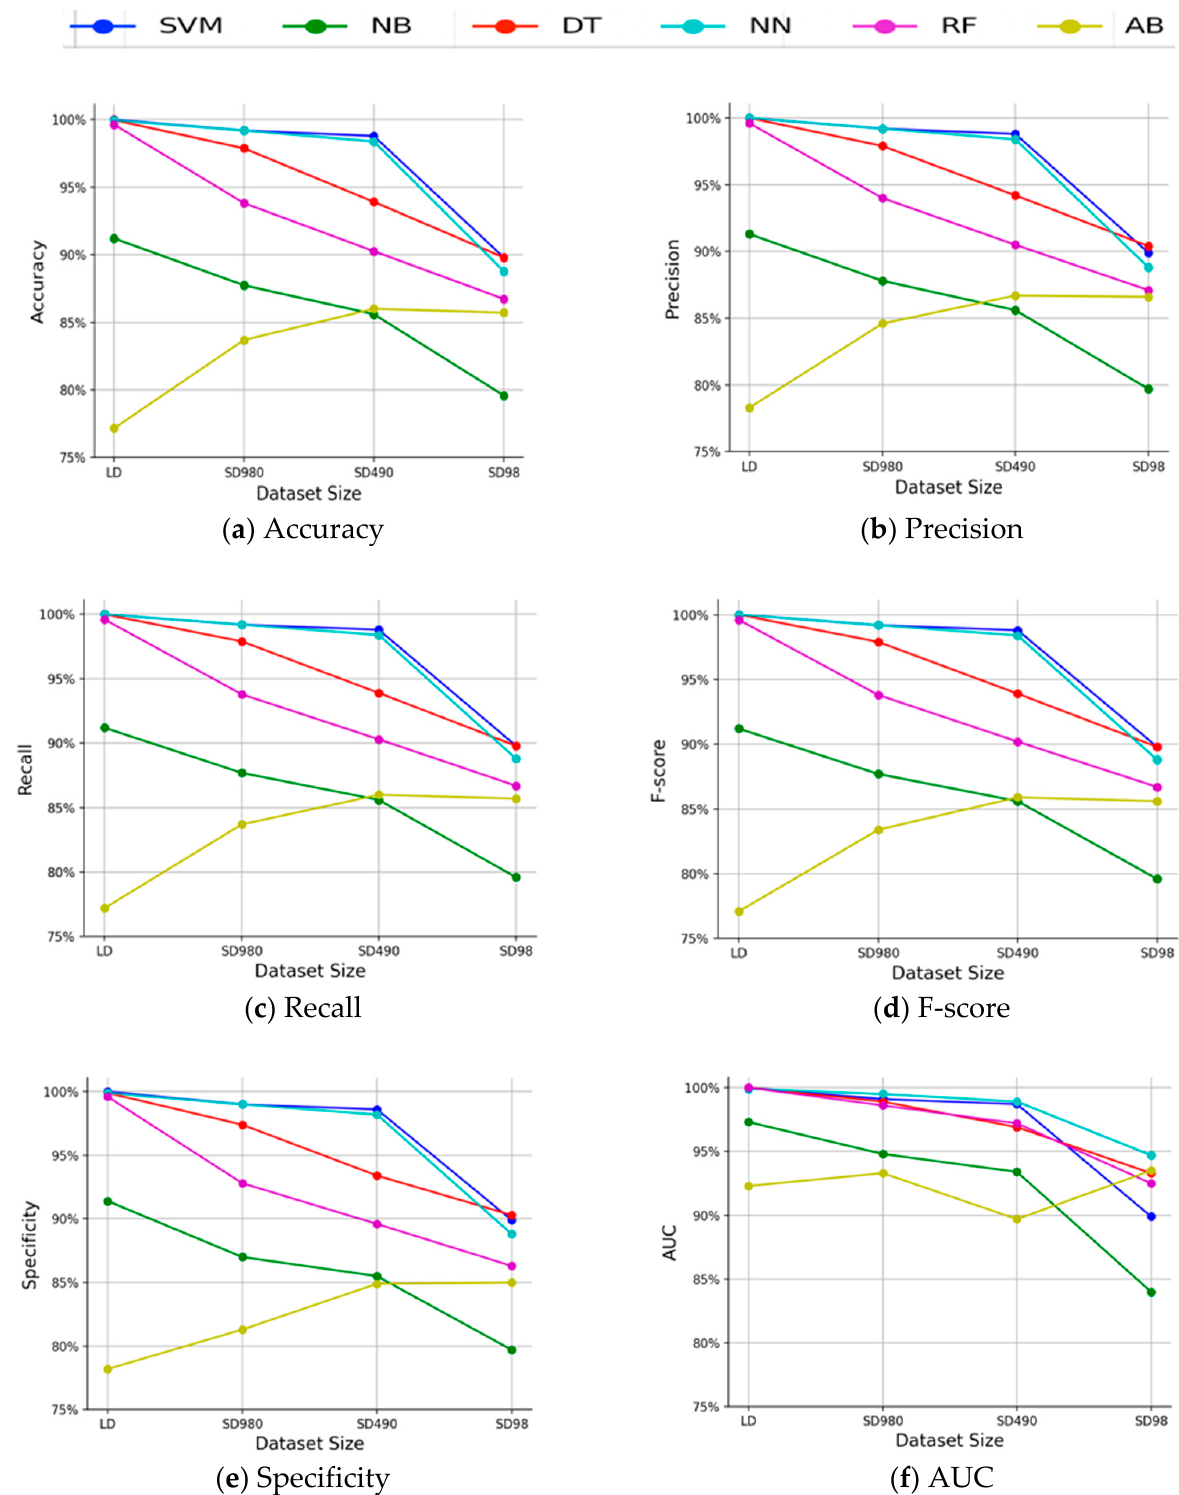
Figure 2. Performance of classifiers with respect to ( a ) accuracy, ( b ) precision, ( c ) recall, ( d ) f-score, ( e ) specificity, ( f ) AUC when trained on diabetes dataset and its small subsets.